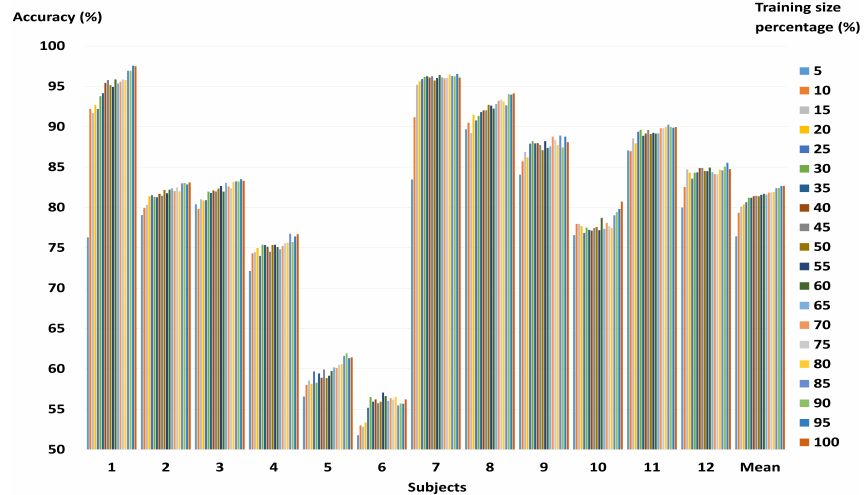
Figure 3. Classification accuracy based on reduction rate of whole training data on individual subjects.